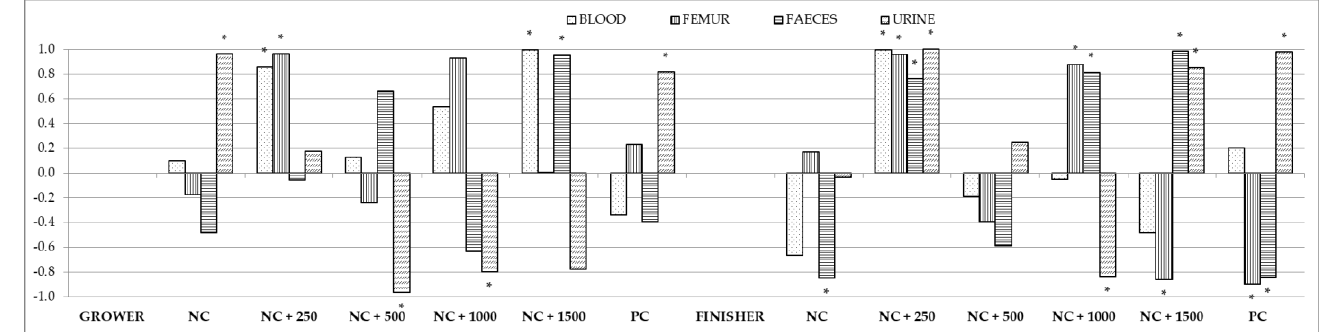
Figure 3. Correlations between content of calcium in the chyme and in the blood, femur, feces, and urine. Asterisks indicate significant correlations at p < 0.05.